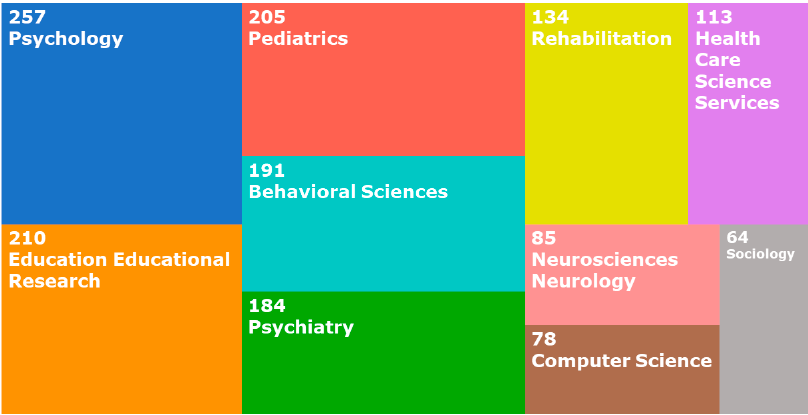
Figure 3. Most frequent research areas in the bibliographic study.